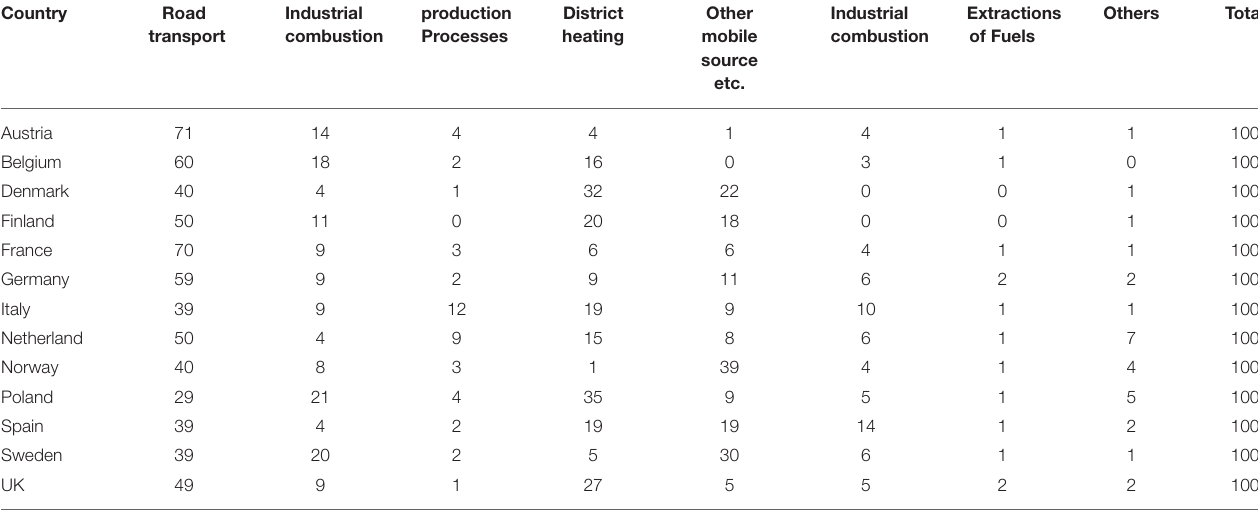
TABLE 1 | Sources of nitrogen oxide emission in European countries. Country Road